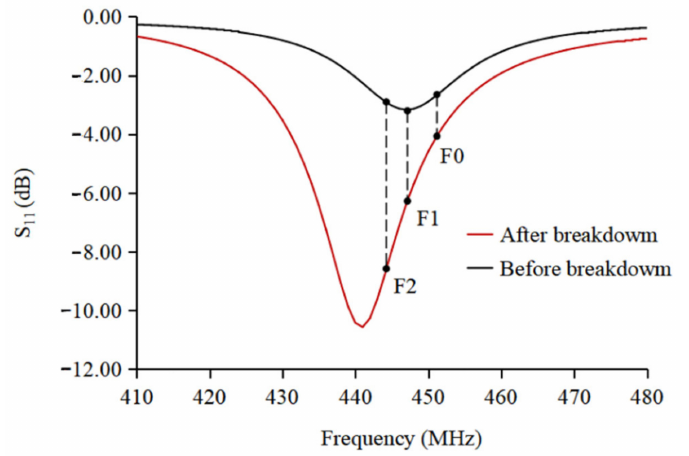
Figure 7. The S 11 and input frequency curves of the resonator before and after gas breakdown. F0 is the starting sweep frequency. F1 is the frequency with minimum return loss before breakdown. F2 is any frequency between F1 and the frequency with minimum return loss after